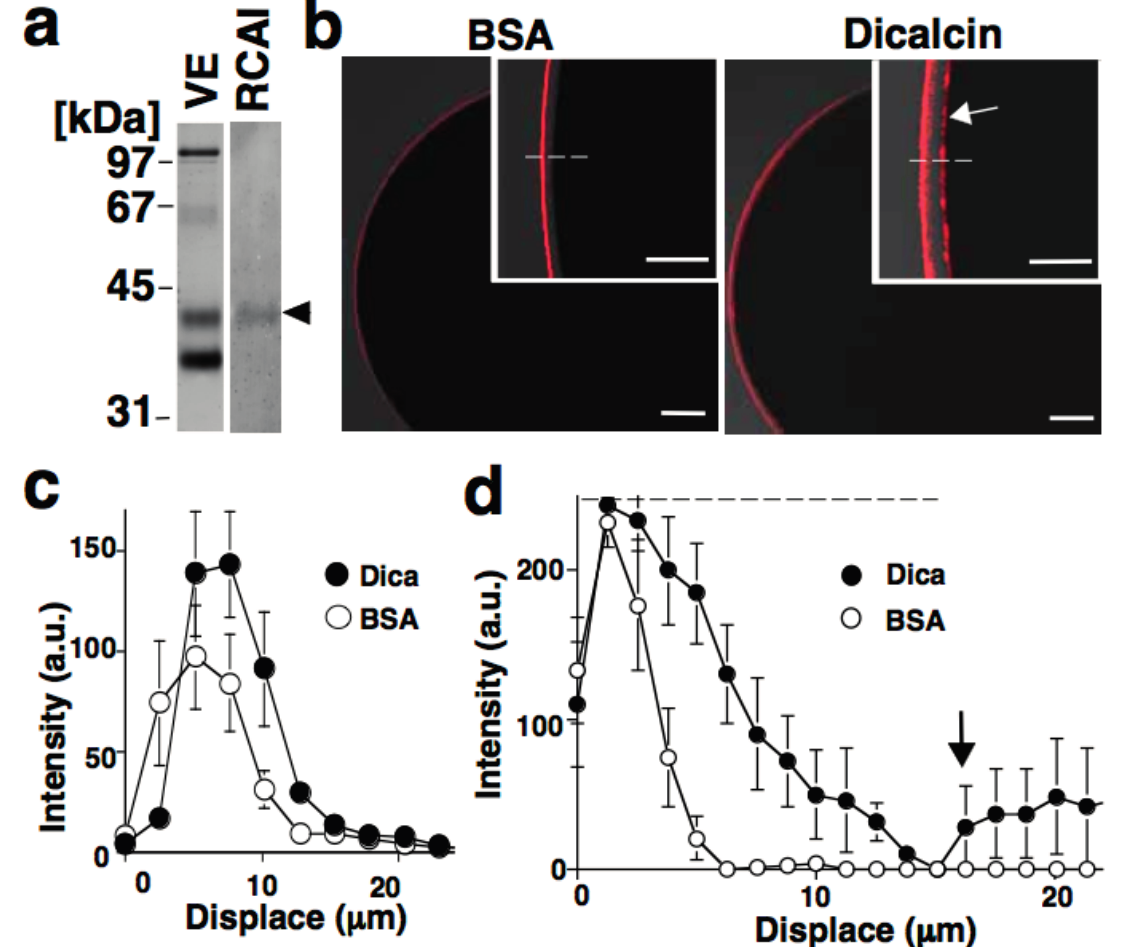
Figure 1. Dicalcin-mediated change in RCA-I reactivity of the zona pellucida (ZP). ( a ) Blots of the vitelline envelope (VE) were treated with rhodamine-labeled RCA-I. RCA-I recognizes ZPC ( arrowhead ); ( b ) Representative confocal images of a Xenopus laevis egg treated with rhodamine-labeled RCA-I. Unfertilized eggs were pretreated with bovine serum albumin (BSA) or dicalcin, followed by RCA-I staining. Insets: higher magnification images. The egg plasma membrane is indicated ( arrow ). Scale bar: 50 μ m; ( c ) Averaged line scans of RCA-I staining across the frog ZP under lower-sensitivity detection. The position where the RCA-I signal starts to increase is designated as 0 μ m in the x-axis; ( d ) Averaged line scans of RCA-I staining across the frog ZP under higher sensitivity detection. An increase in RCA-I signal at the interface between VE and egg plasma membrane is indicated ( arrow ). Reproduced from Miwa et al ., (2010) [12] with permission of the